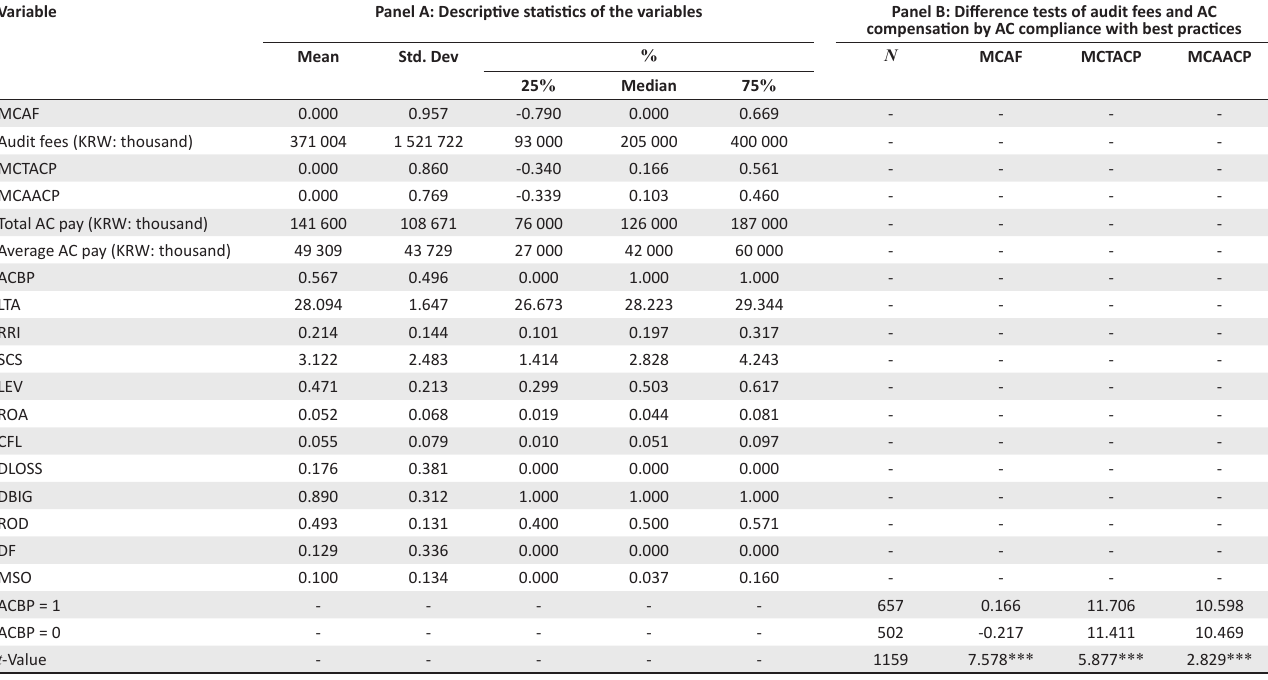
TABLE 2: Descriptive statistics and the difference tests. Variable Panel A: Descriptive statistics of the